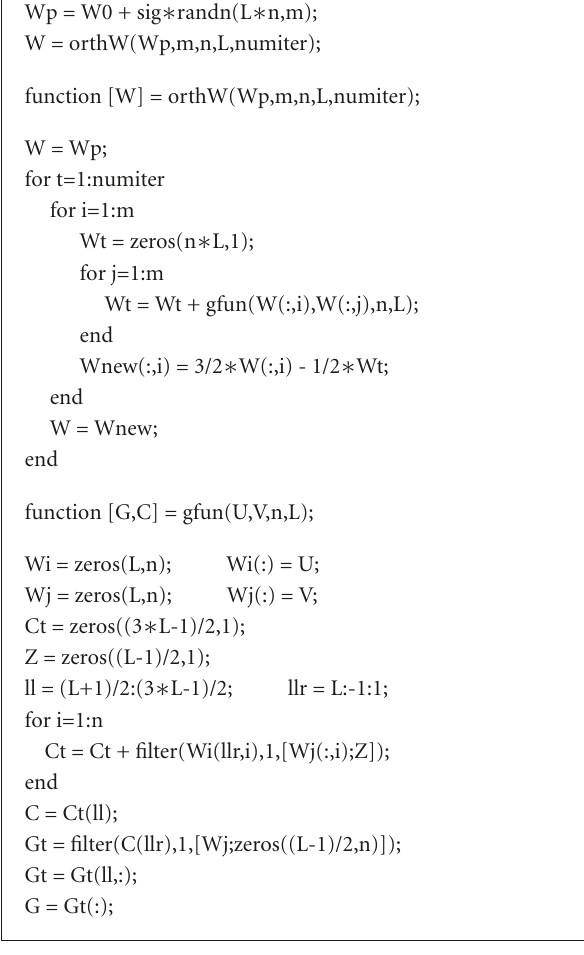
Algorithm 1: MATLAB implementation and testing program for the adaptive paraunitary